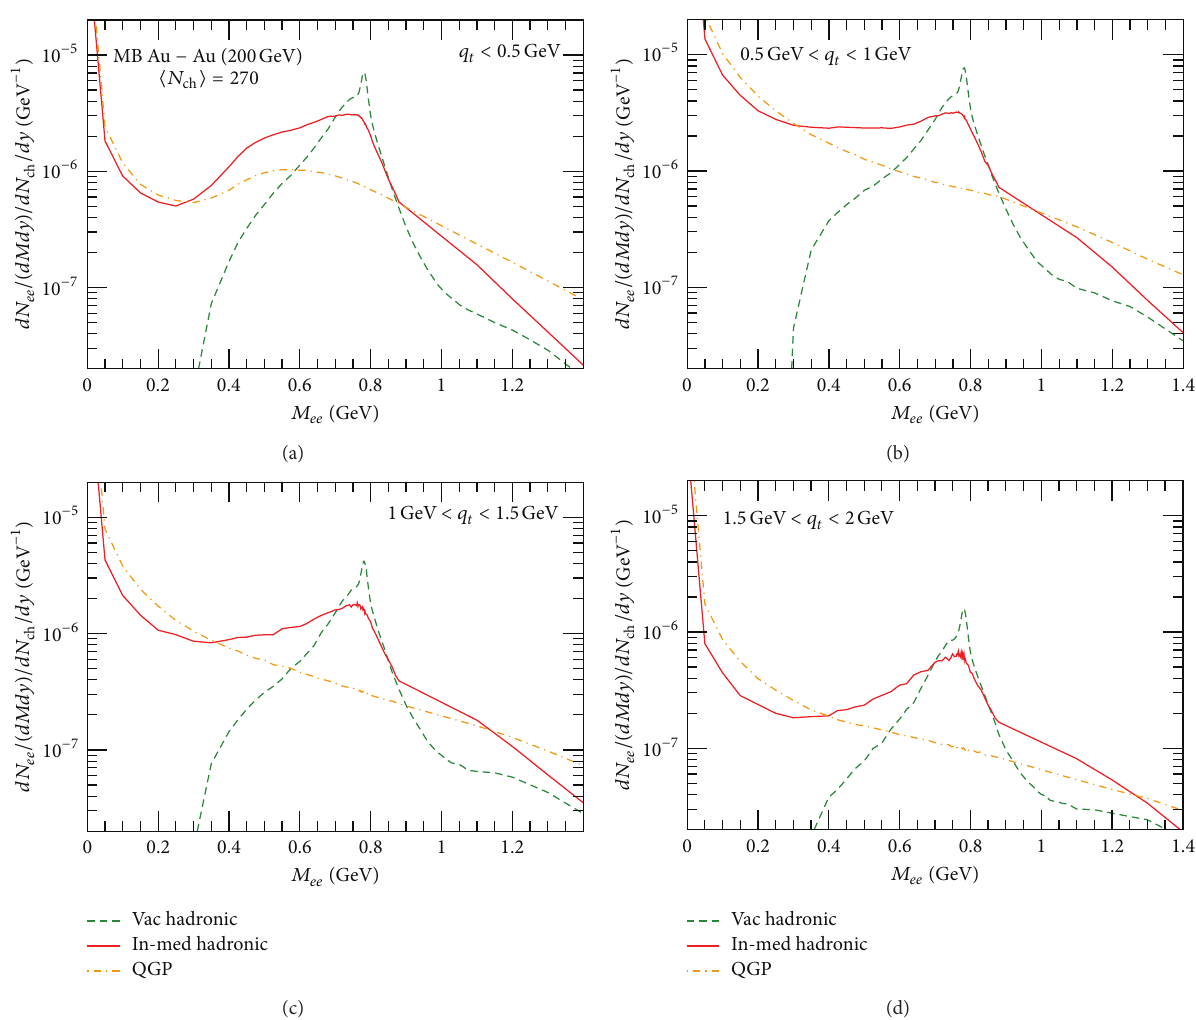
Figure 7: Dilepton invariant mass spectra in different bins of transverse momentum from thermal radiation of QGP (dash-dotted line) and hadronic matter (solid line: in medium, dashed line: vacuum spectral function) in MB Au-Au(200 AGeV) collisions; experimental acceptance as in Figures 5 and